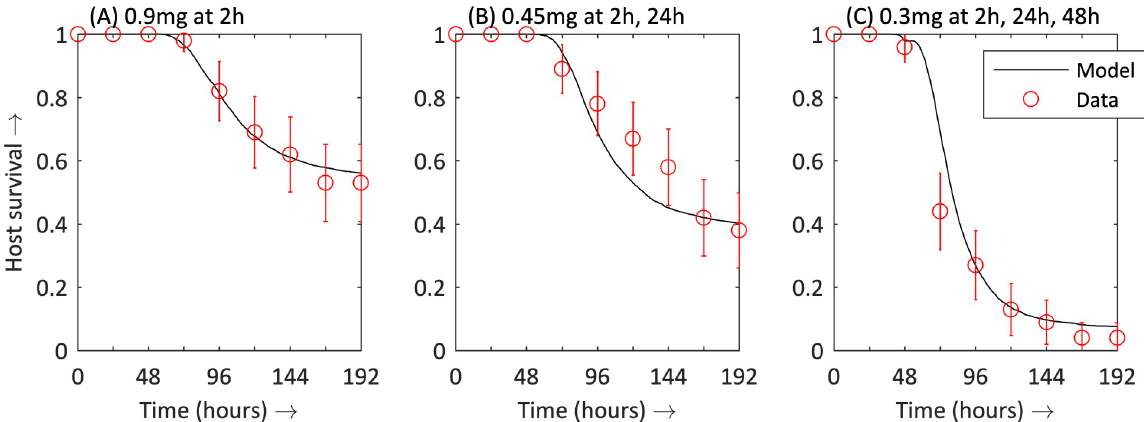
Fig 2. Comparison of mathematical model and experimental results for survival rates for different ‘fixed dose’ treatments, with 0.9 mg either administered as a single dose, or split equally over 2 days, or split equally over 3 days: (A) 0.9 mg administered at 2 h; (B) 0.45 mg administered at 2 h and at 24 h; (C) 0.3 mg administered at 2 h, 24 h and 48 h. n = 45 for biological experiments; n = 5000 for mathematical model.